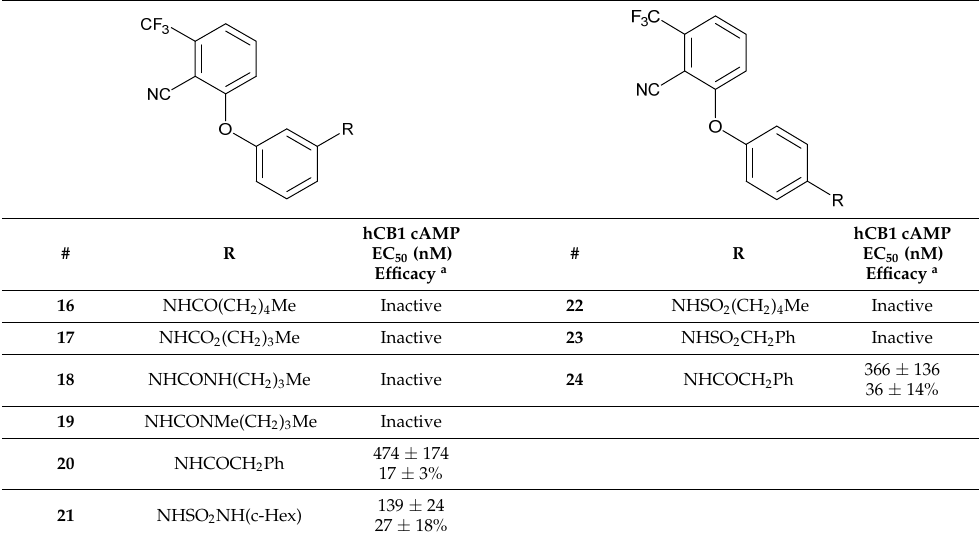
Table 2. Investigation of linkers and para-substitutions.